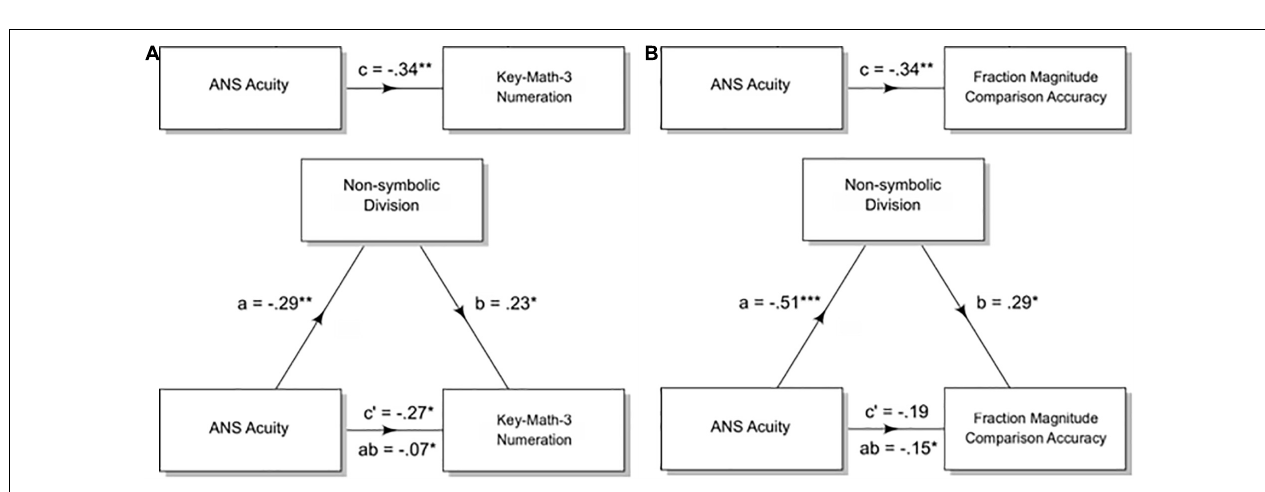
FIGURE 4 | Children who cannot recognize the division symbol ( ÷ ) or cannot solve symbolic division are able to perform non-symbolic and symbolic approximate division. Children’s performance on the non-symbolic and symbolic division tasks broken down by their performance on the formal division test. The feedback and no feedback trials are combined for each task. Boxes indicate median and first and third quartiles. The whiskers indicate 1.5 multiplied by the interquartile range from the first and third quartiles. The dotted line represents chance performance. Each point reflects one participant’s accuracy.